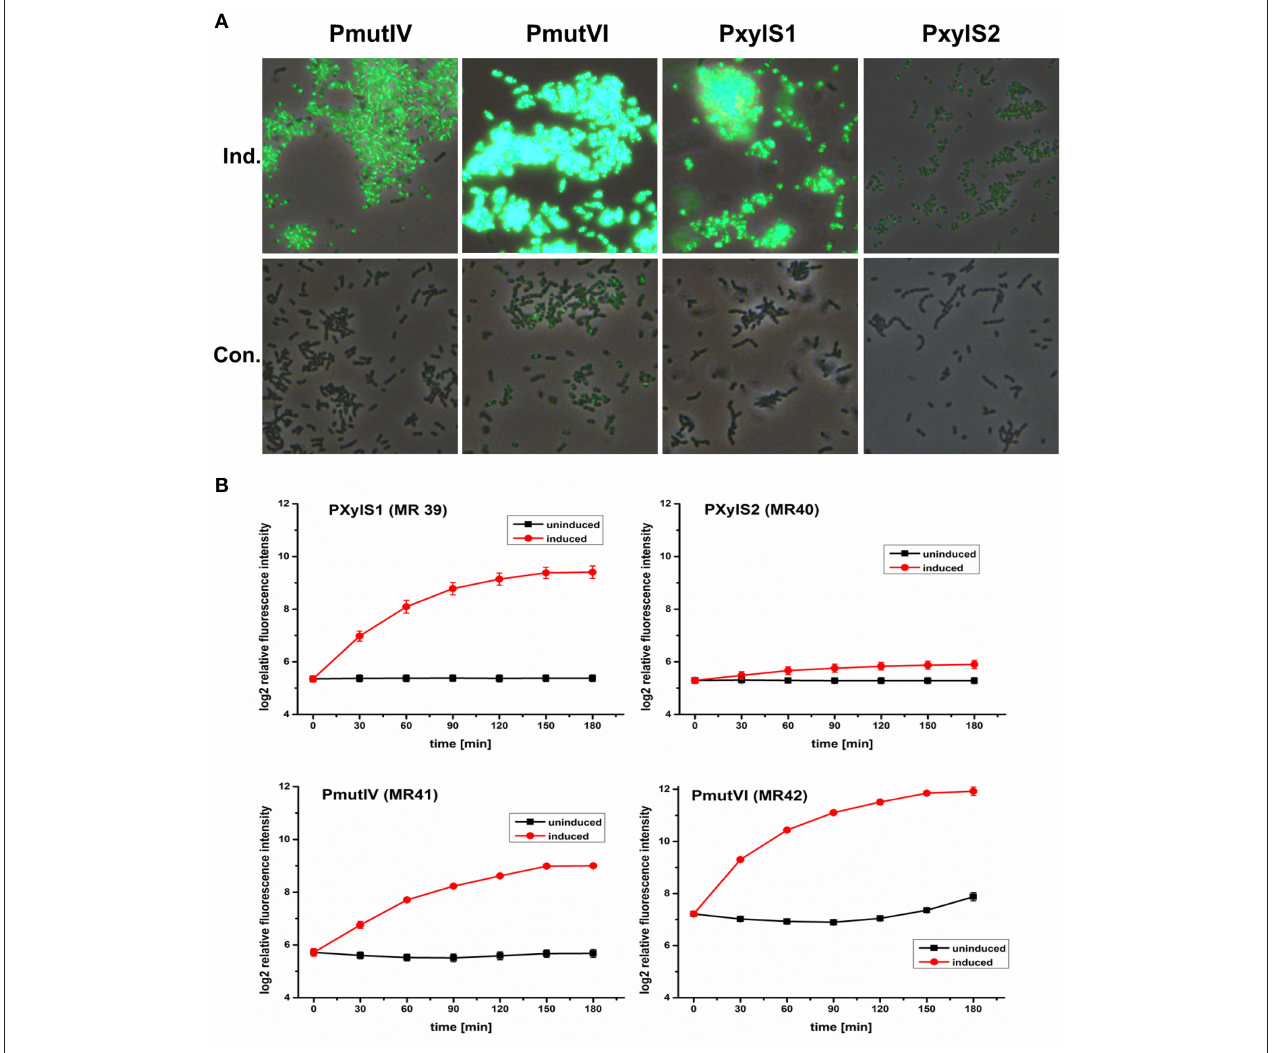
FIGURE 2 | Comparison of the expression strength and basal transcription of different inducible GFP + -DivIVa reporter strains in S. mutans UA159. D-xylose inducible strains carrying a chromosomal gfp + -divIVa fusion construct under the control of the XylS1 (MR39) and XylS2 (MR40) promoter cassettes, respectively, were constructed in S. mutans . In addition DivIVa reporter strains inducible by the competence stimulating peptide (MIP) and carrying the mutacin IV (PmutIV, MR41) and mutacin VI promoter (PmutVI, MR42) were generated. Strains MR39-42 were grown in complex THBY medium to early exponential growth phase (OD 600 = 0.2) and GFP + -DivIVa expression was fully induced with either 2 µ M MIP (pMR41-42) or 1.5% (D)-Xylose (MR39-40). 0, 30, 60, 90, 120, 150, and 180 min post induction cells were collected, washed and analyzed using fluorescence microscopy. In (A) overlay microscopic images (green fluorescence/phase contrast) of the corresponding induced (upper panel) and uninduced strains (lower panel) 3 h post induction are presented. In part (B) line plots of the relative fluorescence intensity in course of time of strains MR39-42 are shown. For the generation of line plots the GFP fluorescence of 50,000 individual cells was recorded using flow cytometry. Red line plots indicate induced strains, while in the black line plots the fluorescence intensity of the corresponding uninduced strains is shown. The mean and the standard deviation of three independent biological replicates are presented.